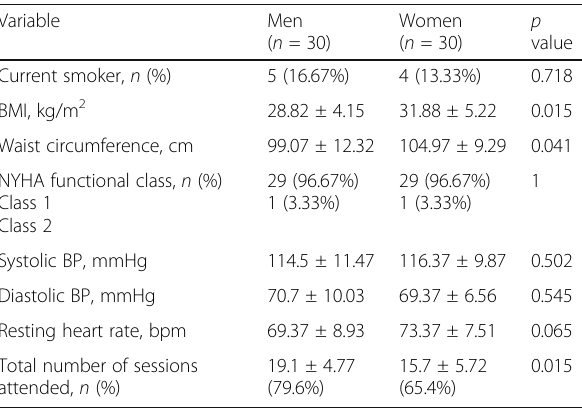
Table 3 Clinical findings and measurements after completion